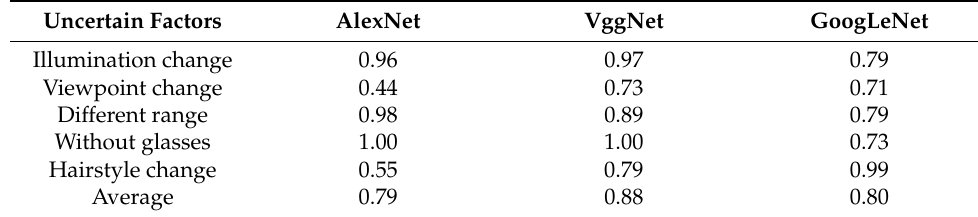
Table 12. AUC comparison under all unstable factors.